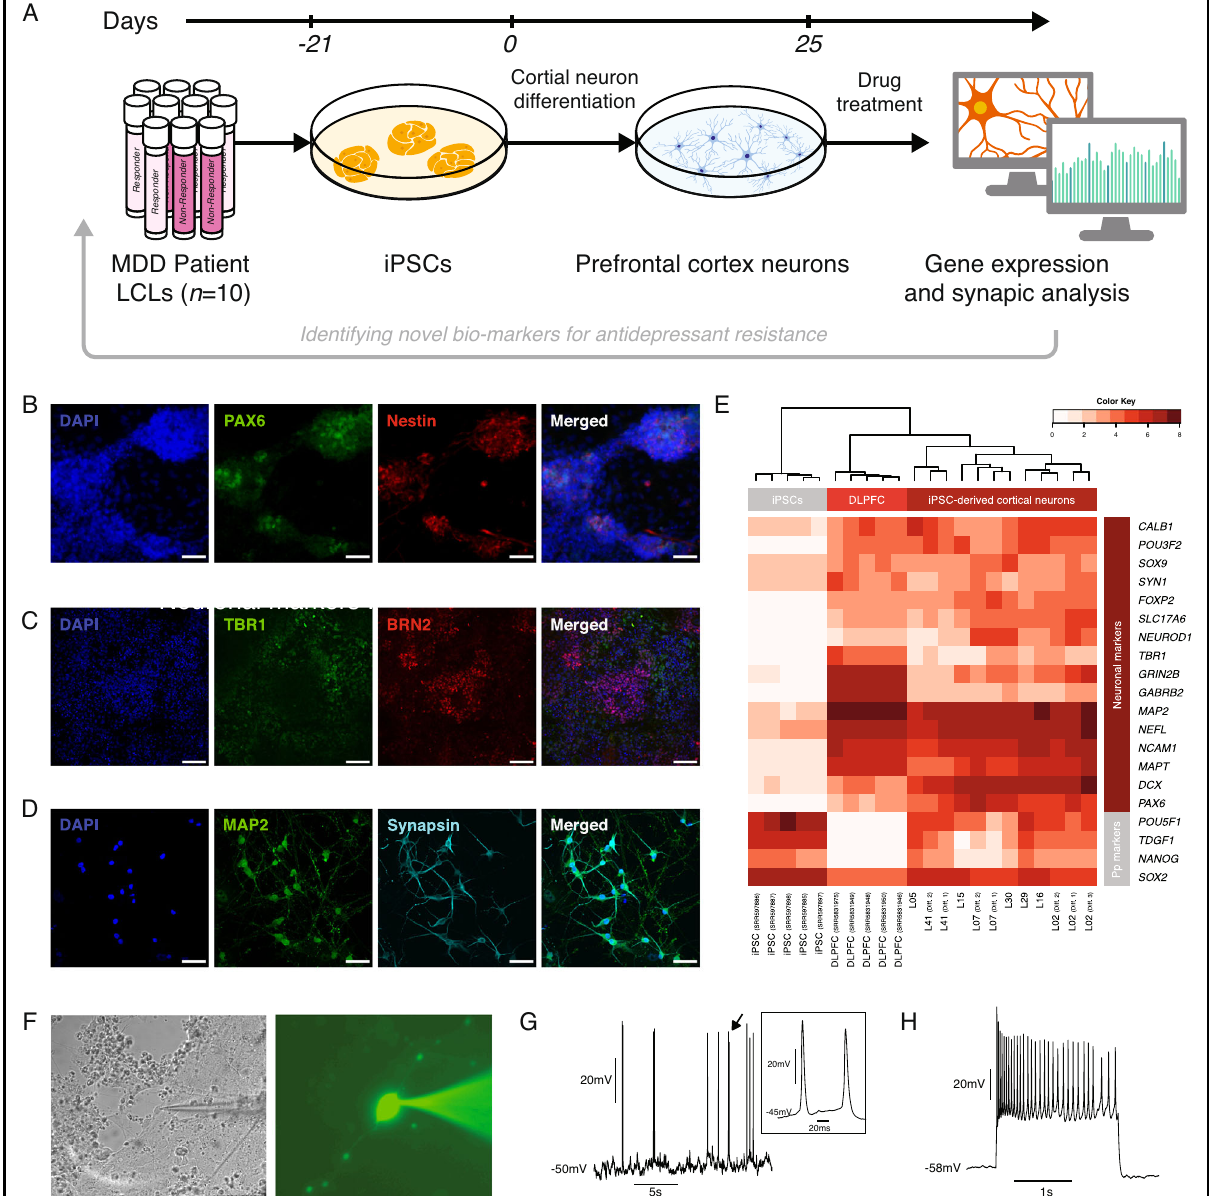
Fig. 1 MDD patient LCLs reprogrammed to iPSCs and differentiated into functional cortical neurons. A Schematic illustration protocol and analysis. Major depression disorder (MDD) patient lymphoblastoid cell lines (LCLs) were reprogrammed into induced pluripotent stem cells (iPSCs) using Sendai viruses. iPSCs were then rapidly differentiated into cortical neurons, treated with an antidepressant and analyzed thereafter using immuno fl uorescent staining and RNA-sequencing. B Five days into the differentiation protocol, patient-derived cells were positive for the neural progenitor markers PAX6 and Nestin. Scale bars represent 260 µm. C After 25 days, neurons were positive for the cortical neural markers TBR1 and BRN2. Scale bars represent 100 µm. D Mature neurons were also positive for synapsin and MAP2. Scale bars represent 50 µm. E Neural gene expression of iPSC-derived cortical neurons is similar to postmortem dorsolateral prefrontal cortex (DLPFC) tissues and different from undifferentiated iPSCs. F Differential interference contrast (DIC) (left) and fl uorescent (right) representative microscopy images taken during electrophysiological recording. G Representative whole-cell intracellular recording of spontaneous activity. Inset: two individual action potentials marked by an arrow. H Representative fi ring pattern of a recorded neuron following a prolonged high amplitude depolarization current